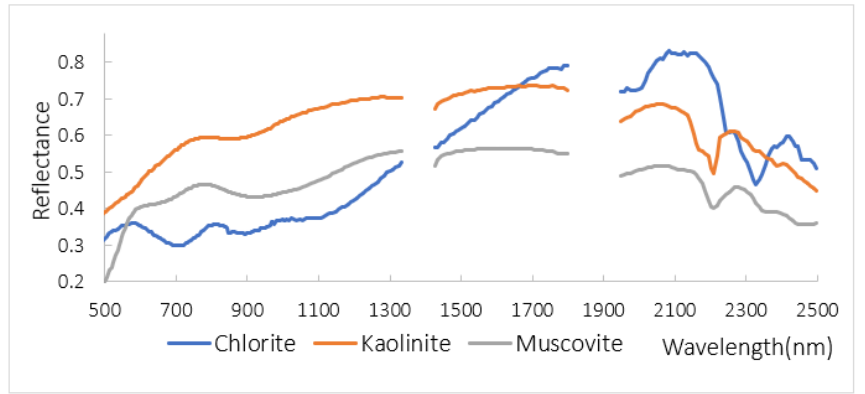
Figure 3. Reflectance spectra of hydrothermal minerals are acquired from the USGS library. They are all resampled at the centre of the GF-5 bands (the disconnected part is removed from the GF-5